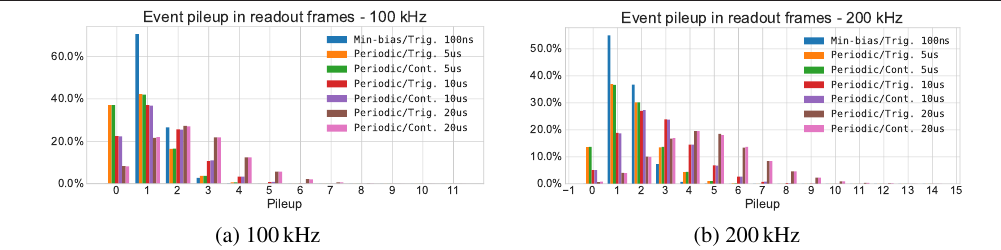
Figure 8: Pileup of events in readout frames in Pb–Pb